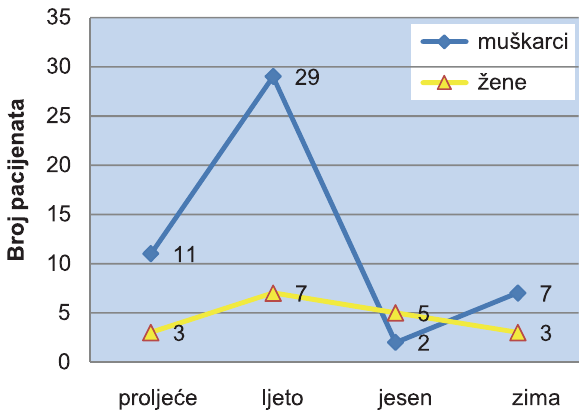
godina. Najveći broj pacijenata sa lumbosakralnom boli torakalnog porijekla je bilo u ljetnom periodu: muškarci 29 (59,18%), žene 7 (38,88% Slika 2). Najveći broj ispi- tanika muškog spola su bili fi zički radnici: 35 (71,42%, Tabela 4), a kod ženskog spola su to bile osobe koje se bave kancelarijskim radom: 7 (38,88%, Tabela 5). Diskusija